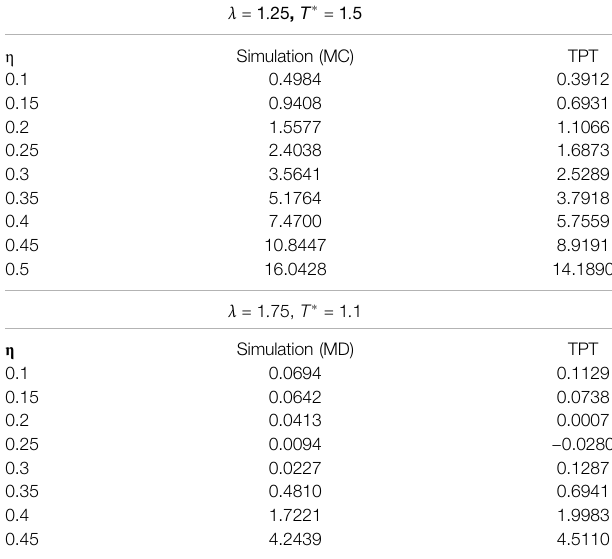
TABLE 3 | Theoretical and simulation results for the reduced pressure at various packing fractions in two isotherms of the parabolic-well fl uid. The labels MC, MD, and TPT stand for Monte Carlo, Event-driven MD, and thermodynamic perturbation theory, respectively. λ (cid:2) 1 . 25 , T p (cid:2) 1 .